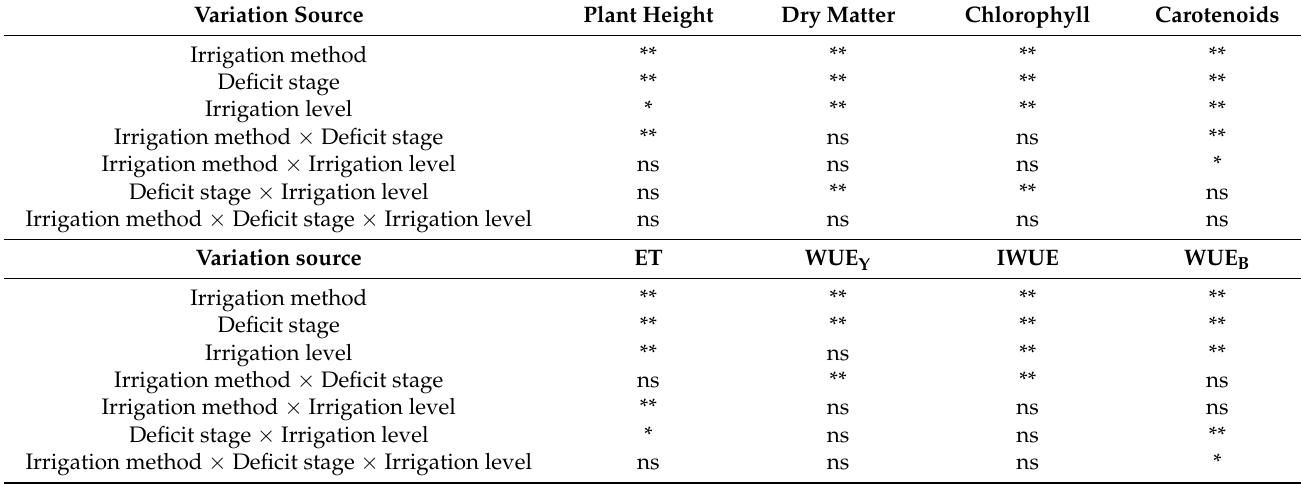
Table 4. Significance levels ( p values) of the effects of the irrigation method, deficit stage, and irrigation level on the plant height, dry matter, chlorophyll, carotenoids, ET , WUE Y , IWUE , and WUE B